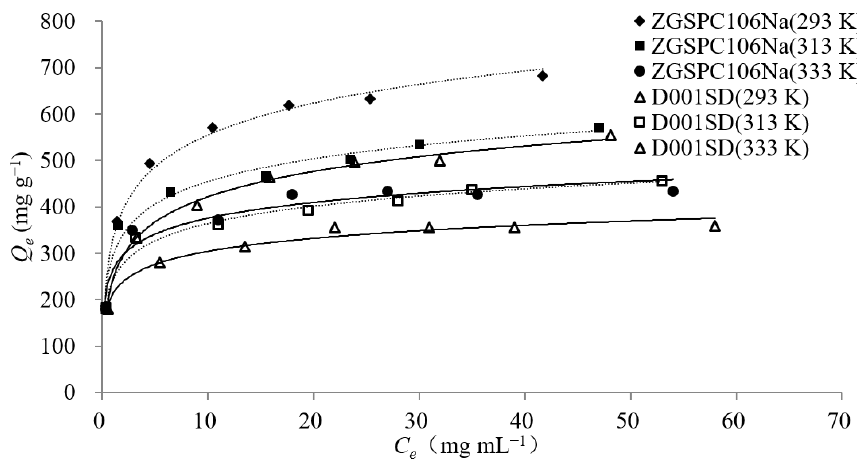
Figure 4. Isothermal adsorption of L-theanine onto ZGSPC106Na and D001SD. behaviors. The result showed that both models could be used to describe the isothermal